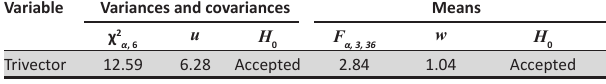
TABLE 5b: Hypothesis tests ( α = 0.05) of equality of means and of variances and covariances on Trivector test and retest vectors for 20 right eyes (see Figure 4) . Variable Variances and covariances